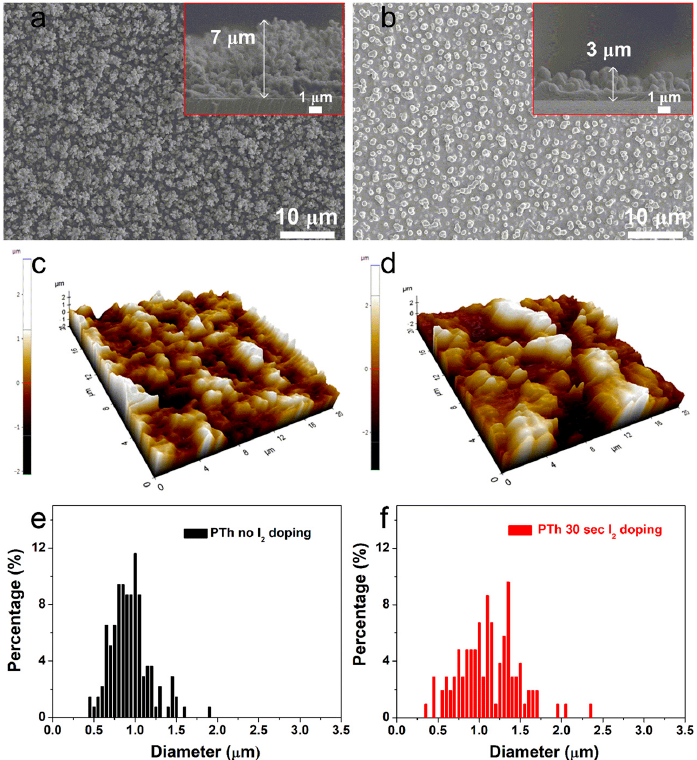
Figure 1. Planar and cross-sectional (insets) SEM images of the plasma polymerized thiophene (PTh) films ( a ) without and ( b ) with I 2 doping. AFM images of the PTh films ( c ) without and ( d ) with I 2 doping. Granularity cumulation distribution charts obtained from AFM images of the PTh films ( e ) without and ( f ) with I 2 doping.